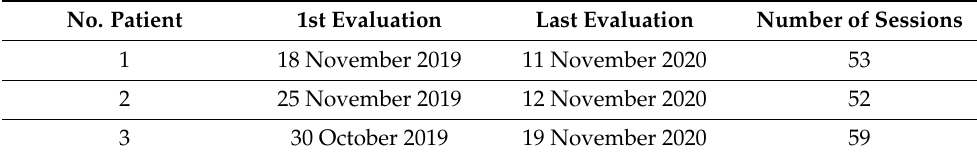
Table 2. Evaluation and